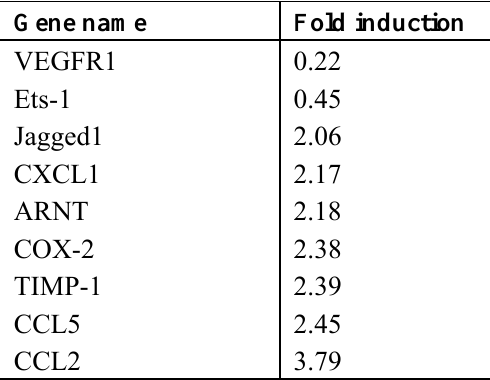
Table 3. Altered expression of angiogenesis-related genes in the VASH1